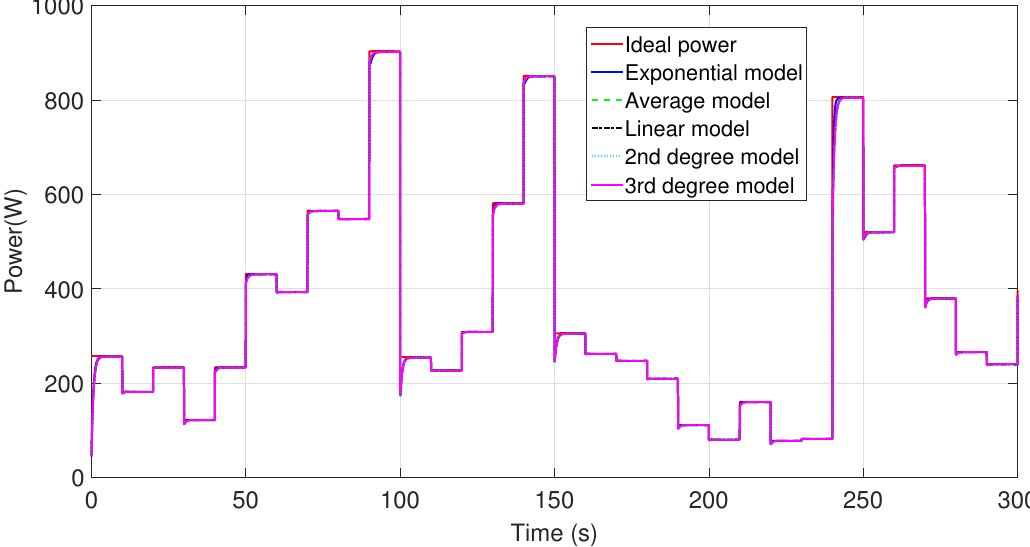
Figure 11. Whole span ideal and instantaneous power for the proposed